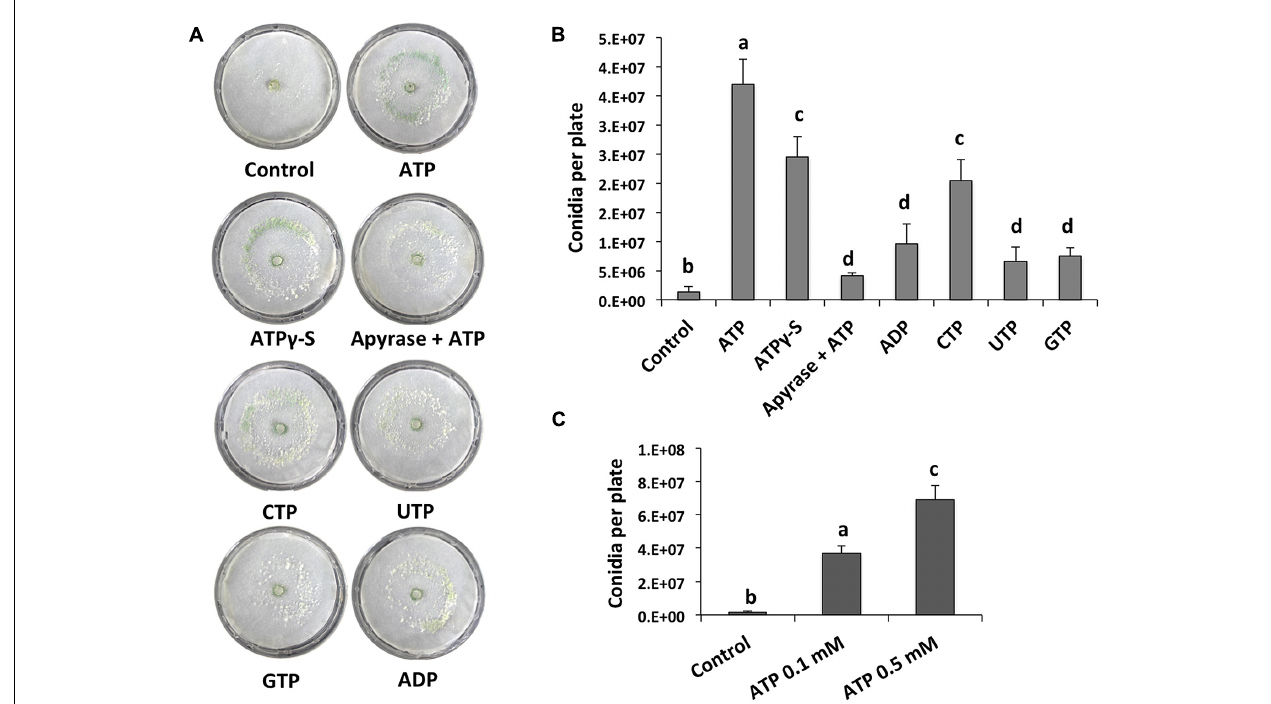
FIGURE 2 | eATP stimulates conidiation. (A) Analysis of theWT strain in response to ATP, ATP γ S, ADP, CTP, UTP, and GTP (0.1 mM), or ATP and 2 units of apyrase. Photographs were taken 48 hours after treatment. An undamaged colony is shown as control. (B) Quantification of conidia produced after the